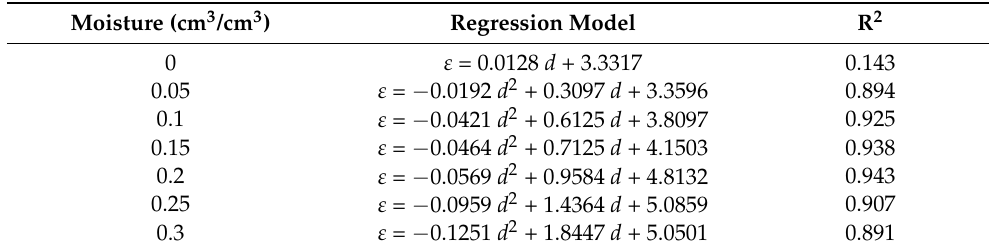
Table 4. Mathematical dependences between sample thickness (cm) and apparent permittivity values read by Sensor B for particle sample